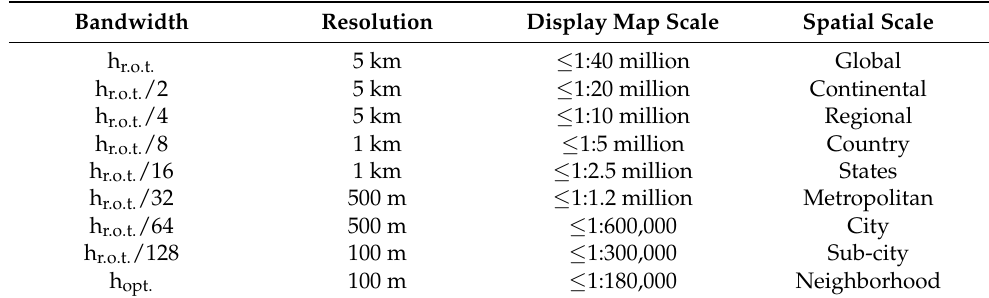
Table 1. Bandwidths used in fixed-bandwidth KDE for detecting hot-spots across spatial scales. h r.o.t. and h opt. are the bandwidths determined based on the ‘rule-of-thumb’ heuristic and through optimization, respectively. Smaller bandwidths are associated with finer spatial resolutions, larger display map scales, and increasingly fine spatial scales at which hot-spots are detected and visualized. Bandwidth Resolution Display Map Scale Spatial Scale h r.o.t. 5 km ≤ 1:40 million Global h r.o.t. /2 5 km ≤ 1:20 million Continental h r.o.t. /4 5 km ≤ 1:10 million Regional h r.o.t. /8 1 km ≤ 1:5 million Country h r.o.t. /16 1 km ≤ 1:2.5 million States h r.o.t. /32 500 m ≤ 1:1.2 million Metropolitan h r.o.t. /64 500 m ≤ 1:600,000 City h r.o.t. /128 100 m ≤ 1:300,000 Sub-city h opt. 100 m ≤ 1:180,000